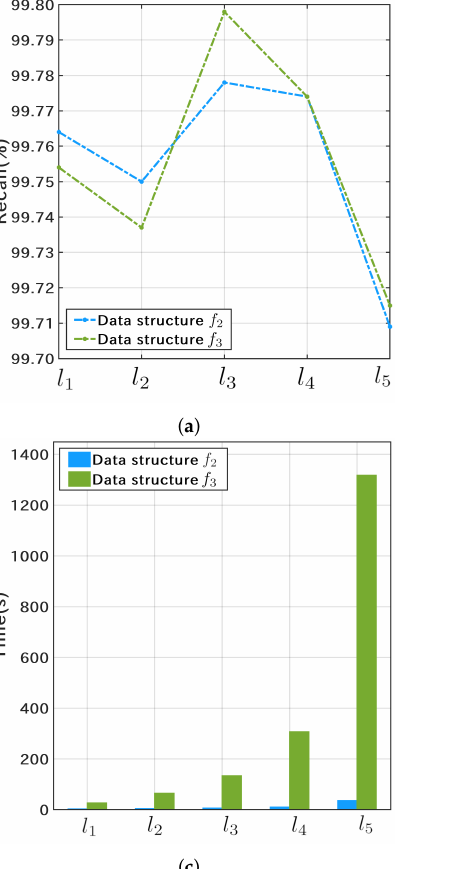
Figure 8. Three-fold cross-validation results of the Catboost classifier on the Nextstrain training dataset S N . ( a , b ) show the recall and F-score curves; ( c ) shows the average time cost per cross- 1 validation; ( d ) shows the learning and testing error